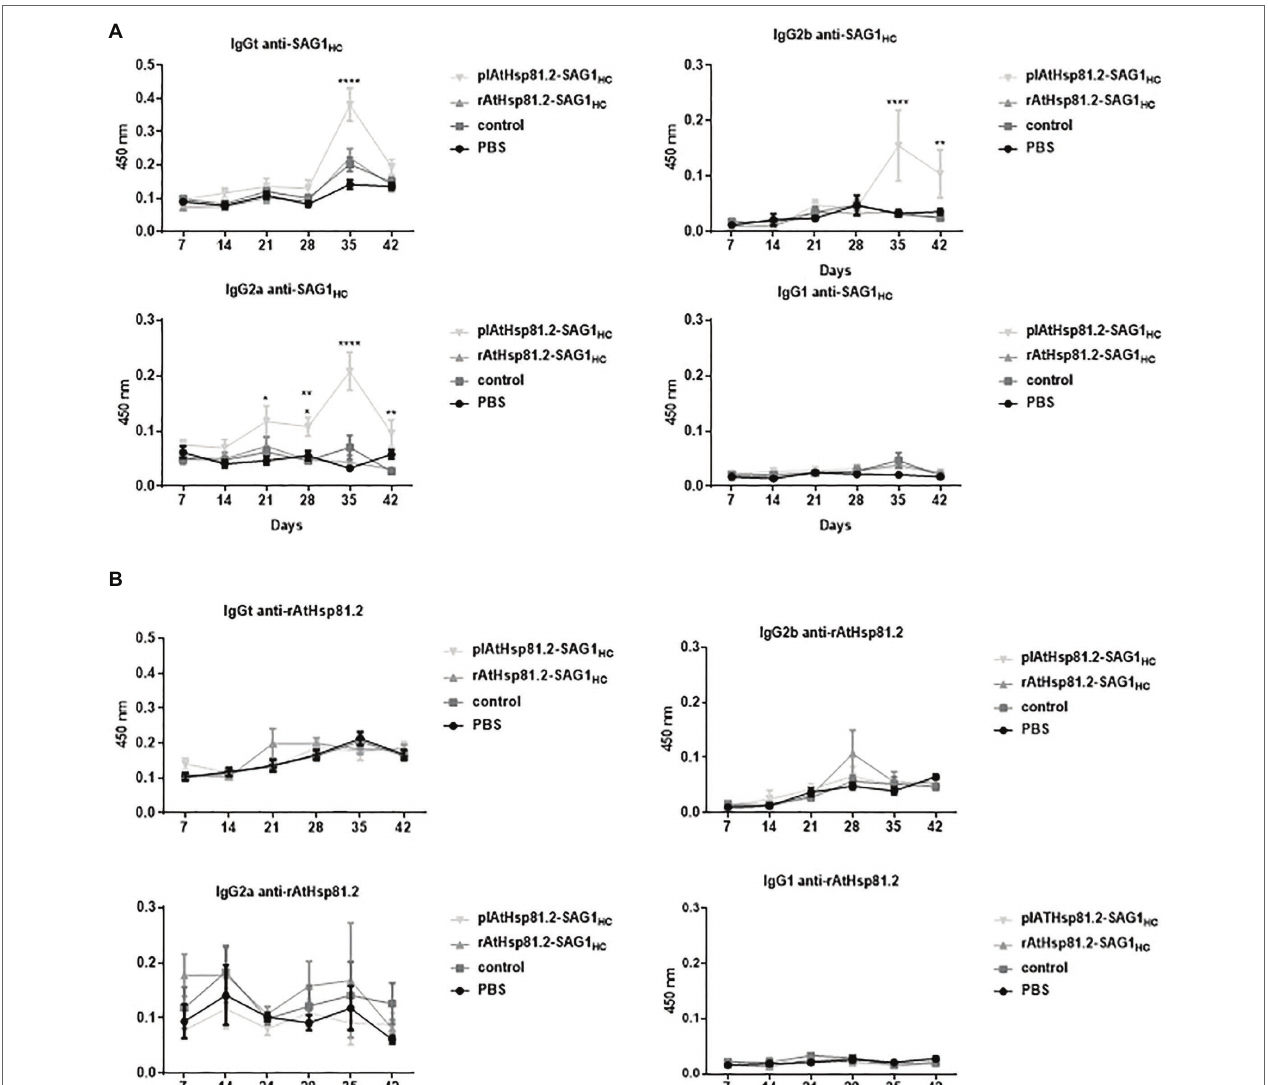
FIGURE 6 | Humoral immune responses against SAG1 HC and AtHsp81.2 prior to challenge with Toxoplasma gondii cysts in mice. (A) Specific immunoglobulin (Ig) Gt, IgG1, IgG2a, and IgG2b antibody production against SAG1 HC . (B) Specific IgGt, IgG1, IgG2a, and IgG2b antibody production against rAtHsp81.2. Serum samples from each group of eight mice were obtained at each time point (7, 14, 21, 28, 35, and 42 days post-infection), and serial dilutions were analyzed by direct ELISA. Mouse serum samples were diluted 1:100 to determine specific antibodies (no saturating dilutions). plAtHsp81.2-SAG1 HC : mice vaccinated with AtHsp81.2- SAG1 HC -infiltrated leaf extracts, rAtHsp81.2-SAG1 HC : mice vaccinated with rAtHsp81.2–SAG1 HC purified from AtHsp81.2-SAG1 HC -infiltrated leaves, control: mice vaccinated with non-infiltrated leaf extracts, PBS: mice vaccinated with phosphate-buffered saline 1X. Results are expressed as the mean of the optical density (OD) 630 ± standard error of the mean (SEM) and represent two experiments. Statistical analysis was performed by two-way ANOVA using Dunnett’s multiple comparisons test. * p < 0.05; ** p < 0.01; **** p <